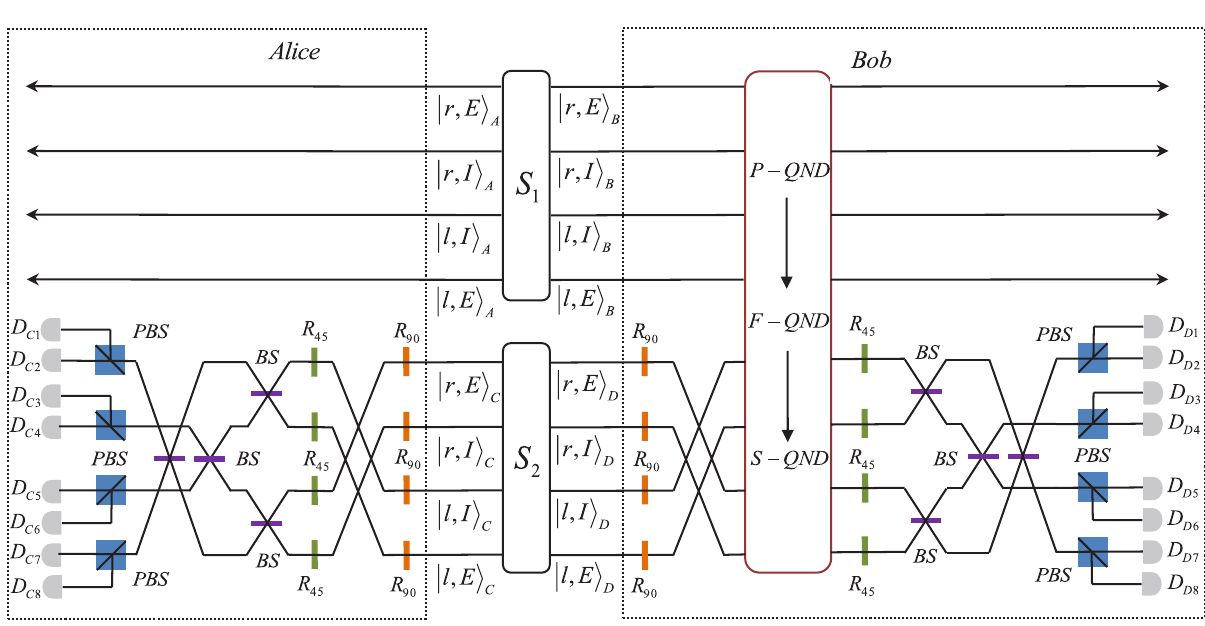
Figure 4. Schematic diagram of our hyper-ECP for a two-photon six-qubit partially hyperentangled Bell state with unknown parameters resorting to cross-Kerr nonlinearity. S 1 and S 2 are two identical partial hyperentanglement sources. R 90 and R 45 are half-wave plates, which are used to rotate the polarization of the o o state by 90 and 45 , respectively. The 50:50 BS is used to accomplish the Hadamard operation for the two longitudinal momentum modes. PBS denotes a polarizing beam splitter which is used to transmit the horizontal polarization component and reflect the vertical polarization component. D represents the single-photon